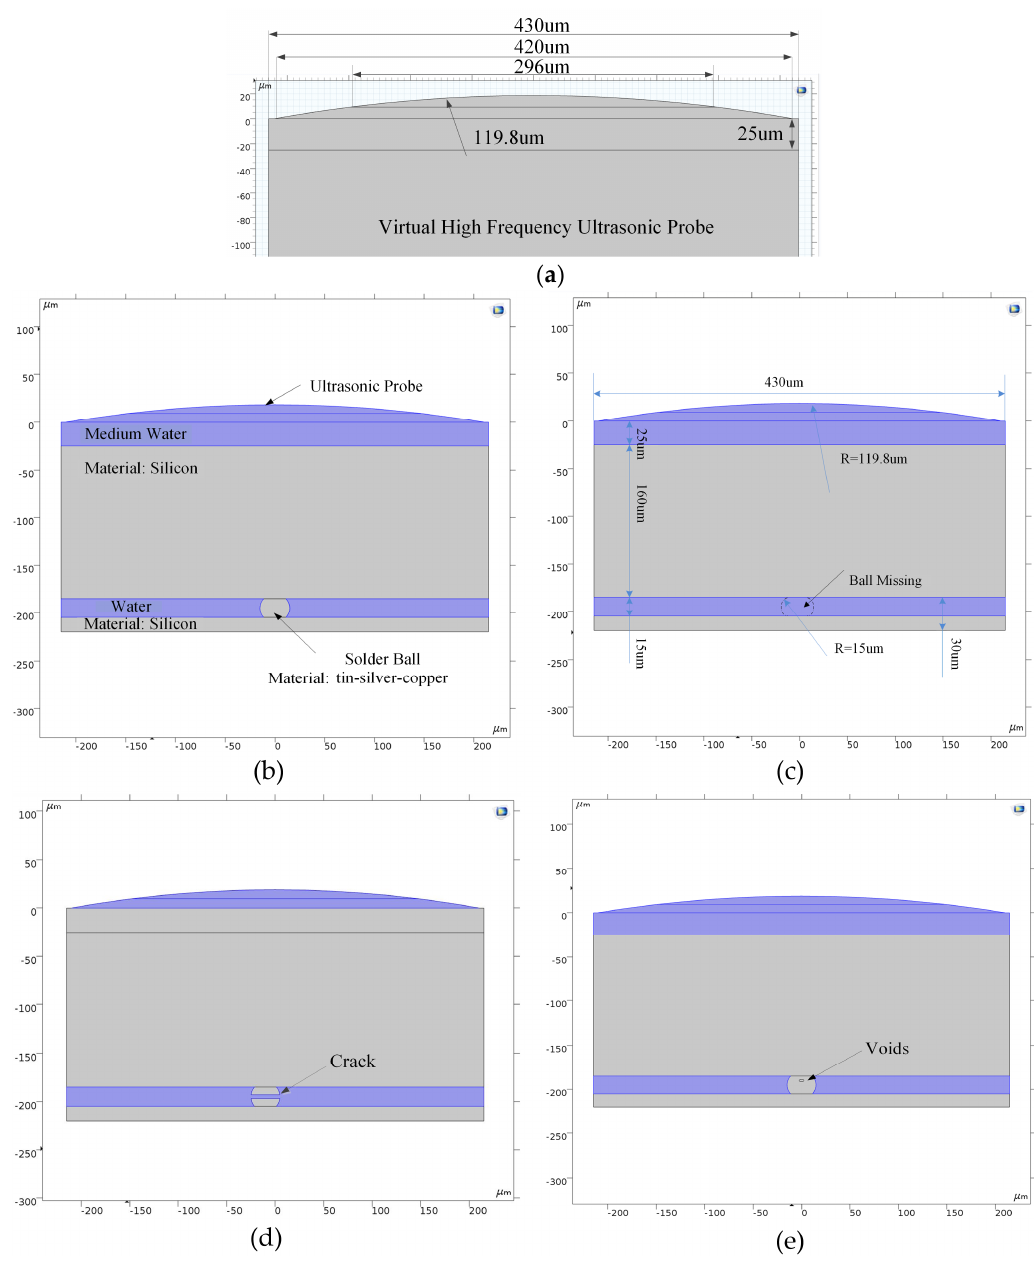
Figure 2. Models of typical defects of solder balls. ( a ) Dimension of virtual probe; ( b ) Model of single solder ball without defect; ( c ) Ball missing; ( d ) Crack; ( e )